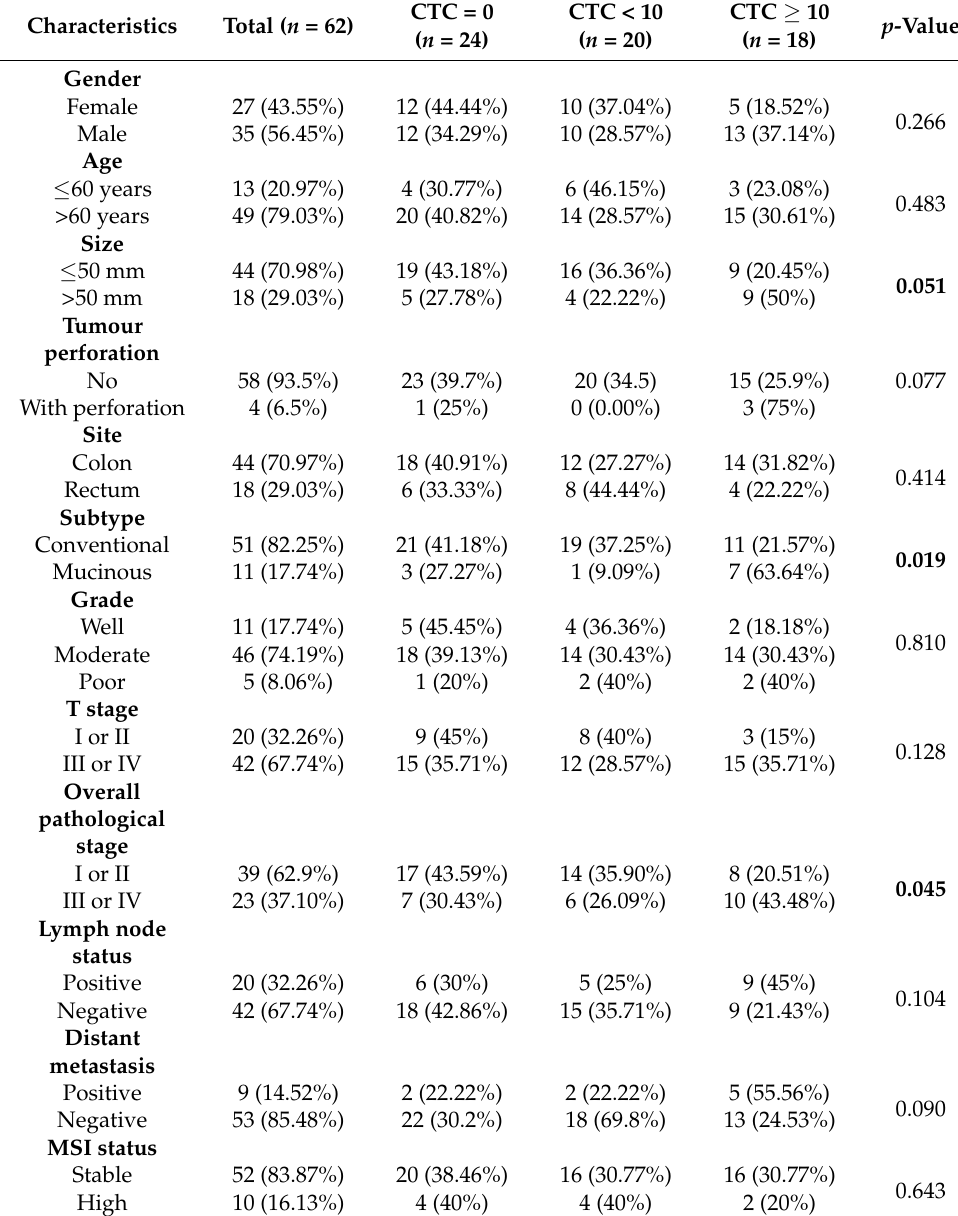
Table 1. The correlations of high vs. low CTC-positive groups with clinicopathological features in patients with